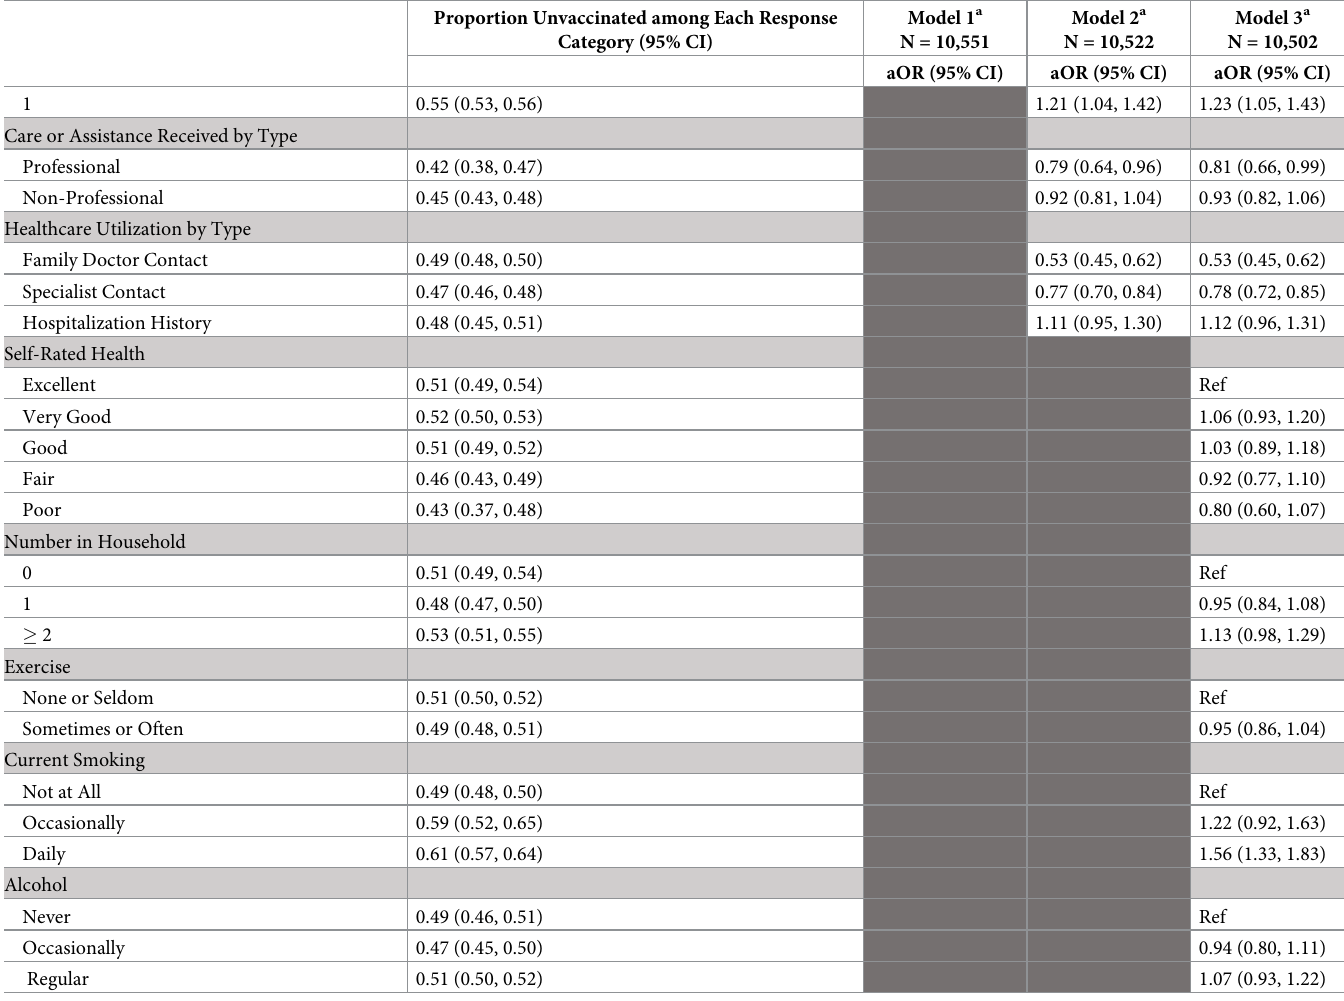
Vaccination coverage did not notably differ across type of CMC. Table 4 presents the results of the logistic regression analysis for adults aged 46–64 years with at least one CMC. The results remained consistent across the partially adjusted models (models 1 and 2) and the fully adjusted model (model 3). For our full model, the odds of remaining unvaccinated were highest for Quebec residents (2.21, 95% CI: 1.95, 2.51), while Nova Scotia residents had the lowest odds of remaining unvaccinated (0.57, 95% CI: 0.48, 0.68), compared to Ontario residents after controlling for all other variables ( Table 4 ).